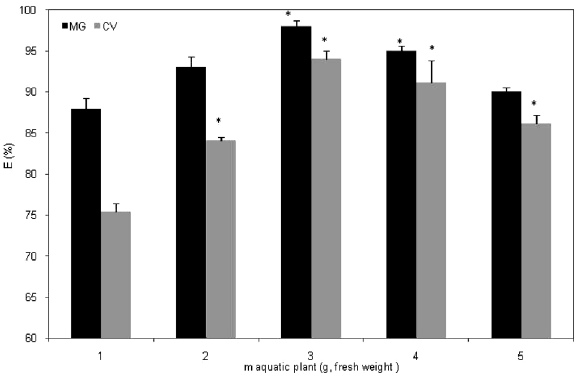
= 40–300 mg/L, m = 3 g (in i plants